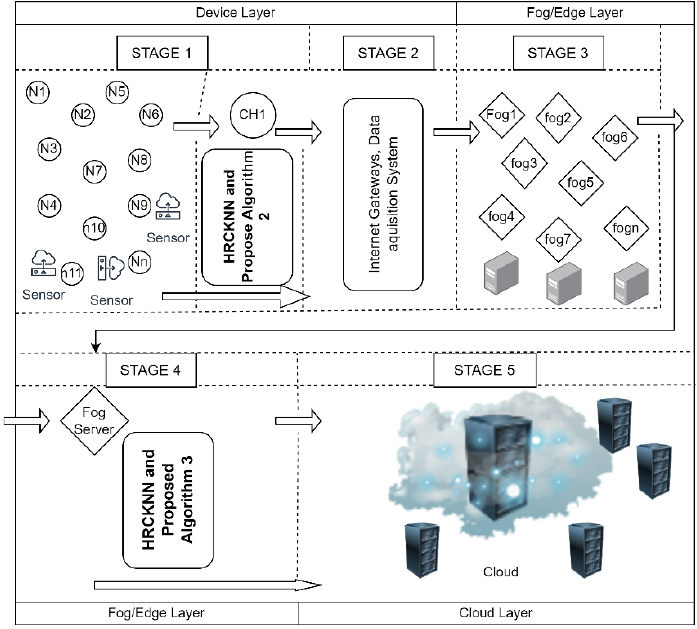
Figure 5. Stages in MLADCF (Proposed Framework).